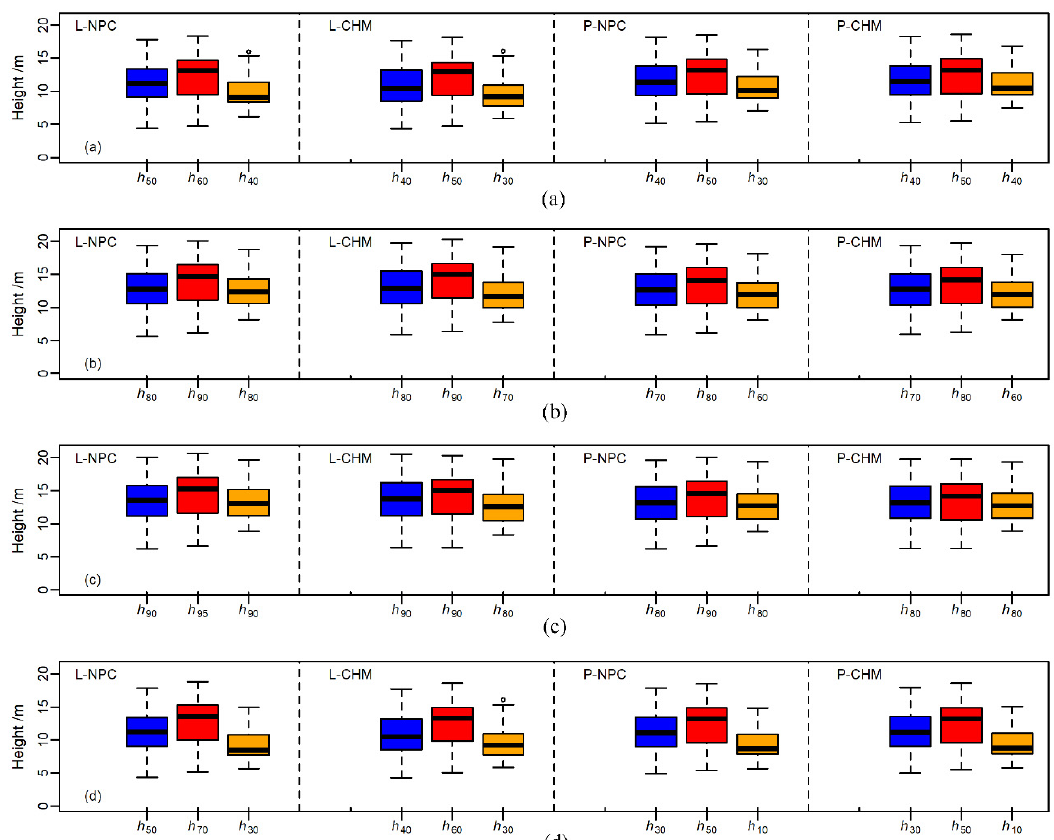
Figure 9. The boxplots of the best explanatories for each stand height modeled by L-NPC, L-CHM, P-NPC, and P-CHM alone. ( a ) Mean height, ( b ) Lorey’s height, ( c ) dominated height, and ( d ) median height. Table 5. The accuracy assessments of the four stand height predictive models from the ULS and USP metrics.